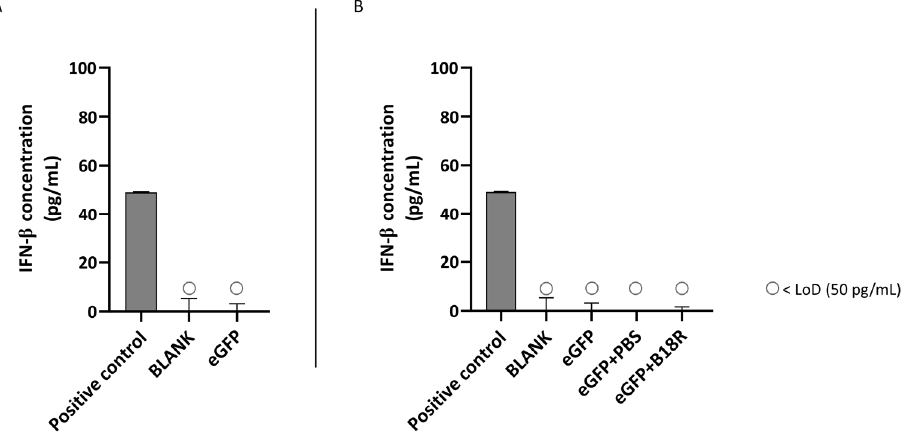
Figure 4. IFN-β production of MIO-M1 cells transfected with mRNA-MessengerMAX lipoplexes with or without B18R co-incubation as determined by ELISA (n = 3 × 3). ( A ) Absolute INF-β concentration in the supernatant 24 h following transfection of MIO-M1 cells with mRNA-MessengerMAX complexes without B18R addition. ( B ) IFN-β concentration, normalized to the group solely receiving mRNA-MessengerMAX complexes (eGFP), in the supernatant of MIO-M1 cells 24 h after transfection with mRNA-MessengerMAX complexes with or without B18R addition. The lowest concentration of IFN-β that could be detected with the used ELISA assay (LoD) was 50 pg/mL. Concentrations below the LoD are assigned with ○ . Both graphs contain a positive control with a concentration of 50 pg/mL derived from the standard curve obtained during the experiment.